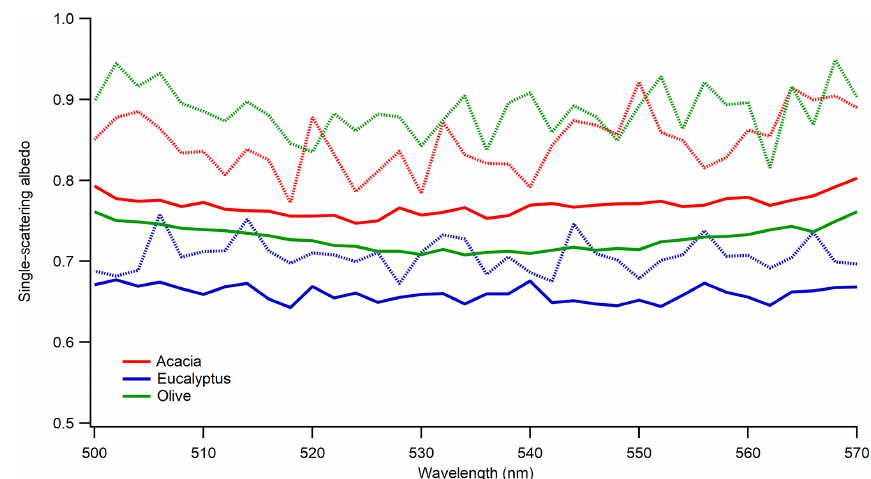
Figure 6. Impact of dark aging on SSA of 300nm sized-selected aerosol emitted during smoldering-dominated combustion. Solid lines are for freshly emitted particles, and dotted lines are for dark aged particles in the chamber. Different colors are for the different fuels listed in the